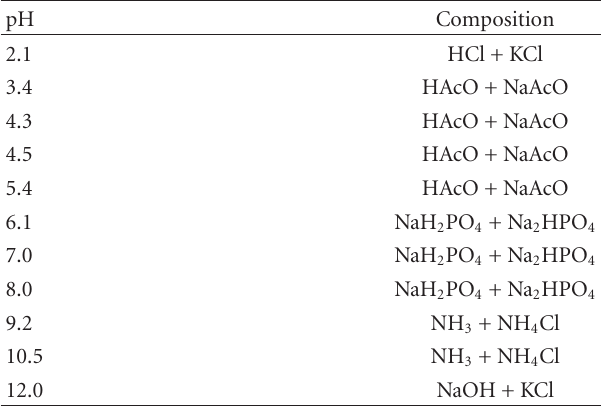
Table 1: Supporting electrolyte bu ff er solutions. pH